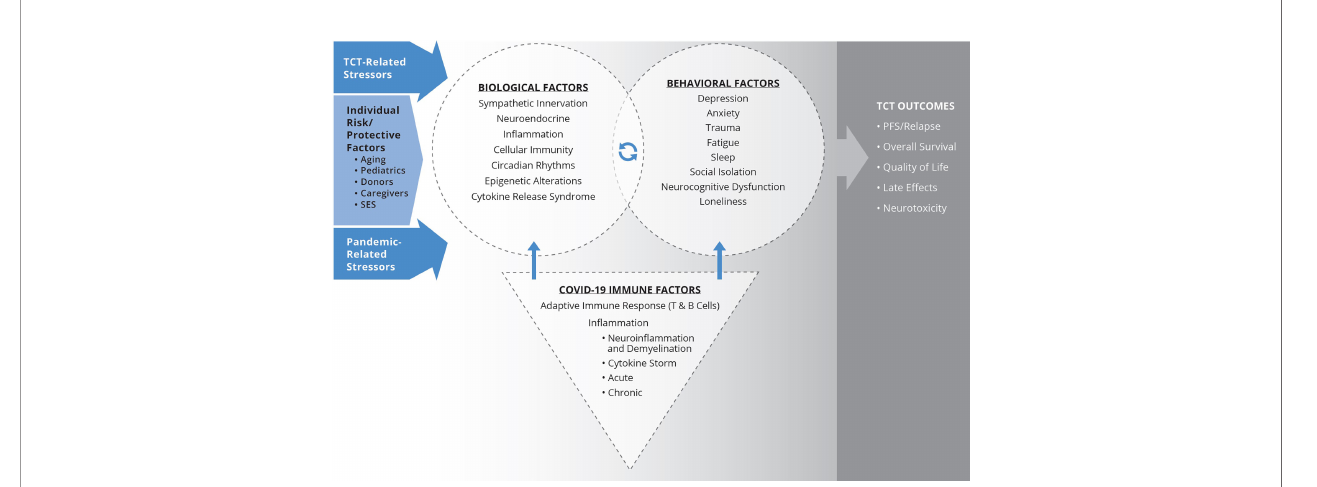
FIGURE 1 | Biobehavioral model illustrating Covid-19 impact for TCT patients. Biological processes affected by TCT, including in fl ammation and disrupted circadian rhythms, alter central nervous system pathways that evoke behavioral symptoms. Stress-related behavioral factors activate HPA and SNS axes and are associated with downstream immunologic and genomic alterations. The products of these pathways, as well as direct sympathetic innervation of the bone marrow microenvironment, can modulate immune recovery and in fl ammation, potentially in fl uencing clinical outcomes following TCT. Behavioral factors also directly relate to quality of life and late effects. Stress and adversity associated with the Covid-19 pandemic can exacerbate biological and behavioral impacts of TCT and biobehavioral mechanisms associated with poorer clinical outcomes. Similarly, infection with SARS-CoV-2 can also adversely affect biobehavioral factors and relationships. The paper further considers the intersection of Covid-19 impacts and individual differences in risk and protective factors, including age, SES, caregiver status, and donor characteristics relevant to biobehavioral processes and TCT